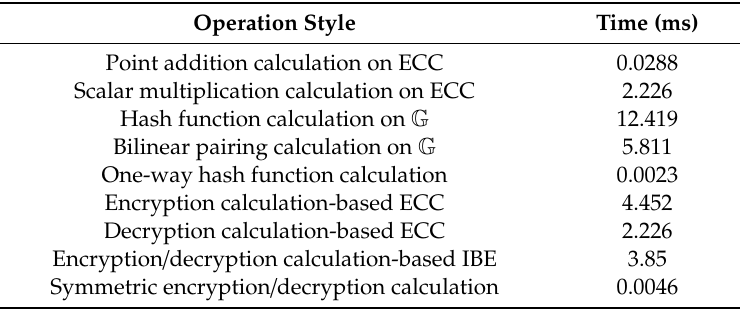
Table 3. Various calculation operation times in the algorithm.